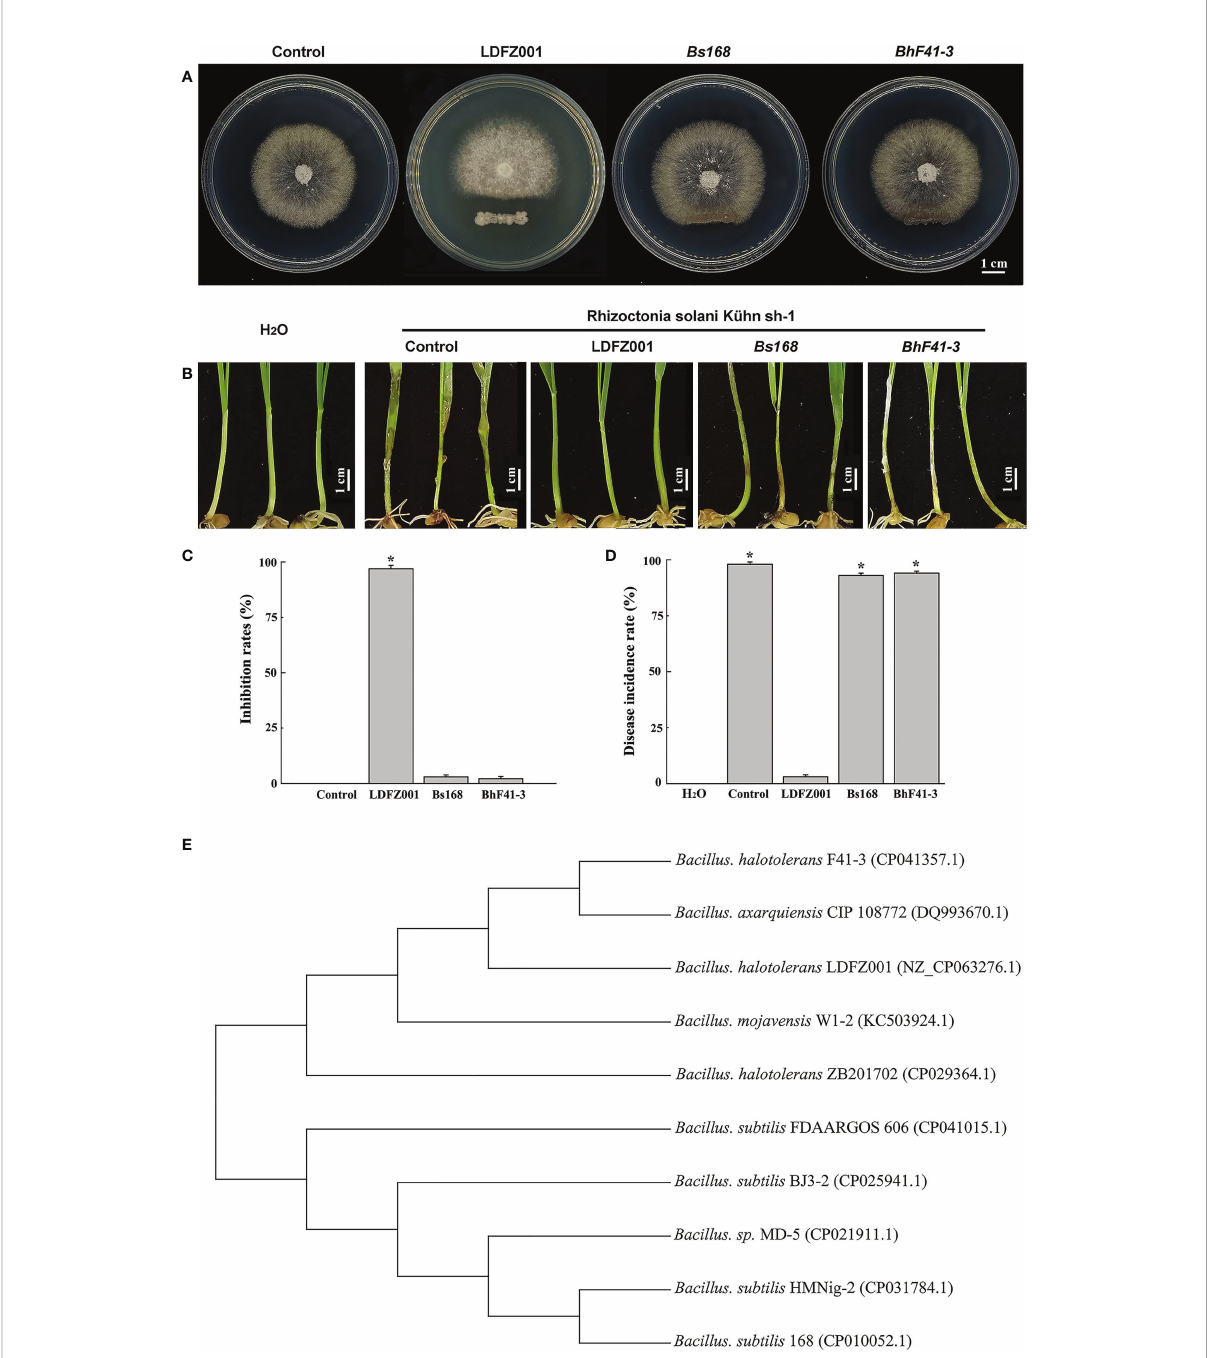
FIGURE 1 Antipathogen activity and phylogenetic relationship analyses. (A) Comparison of the antipathogen activity of B halotolerans LDFZ001 (LDFZ001) with its relative strains Bacillus subtillis 168 ( Bs168 ) and Bacillus halotolerans F41-3 ( BhF41-3 ) against R. solani Kühn sh-1 , a pathogenic fungus strain cased sheath blight disease in crop plants. R. solani Kühn sh-1 inoculated at the center of PDA medium plate was cultured three days at 28°C alone or co-cultured with LDFZ001, Bs168 or BhF41-3 , which was inoculated as a scratch line under the R. solani Kühn sh-1 inoculation spot on each plate. (B) Susceptibility analysis of wheat seedlings pretreated with LDFZ001, Bs168 and BhF41-3 to R. solani Kühn Sh-1.The sodium phosphate buffer was used as negative control (control). Wheat seedlings without any treatment were shown in the left as a control, too. (C) Inhibition rates (IRs) of B halotolerans LDFZ001, B subtillis 168 and B halotolerans F41-3 against R. solani Kühn sh-1 in image (A) . (D) Disease incidence rates (DIRs) in image (B) . Values are the mean ± SD from three independent experiments (n = 30). *P< 0.05. (E) Phylogenetic tree of B halotolerans LDFZ001 and other related taxa was generated based on 16S rRNA sequence. MEGA 7 was used to align the